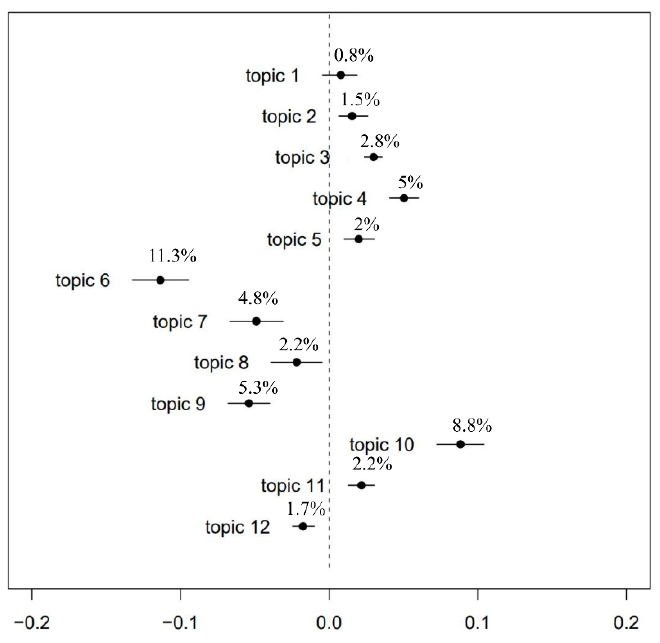
Figure 4. Topic prevalence based on sentiment polarity (positive vs. negative).